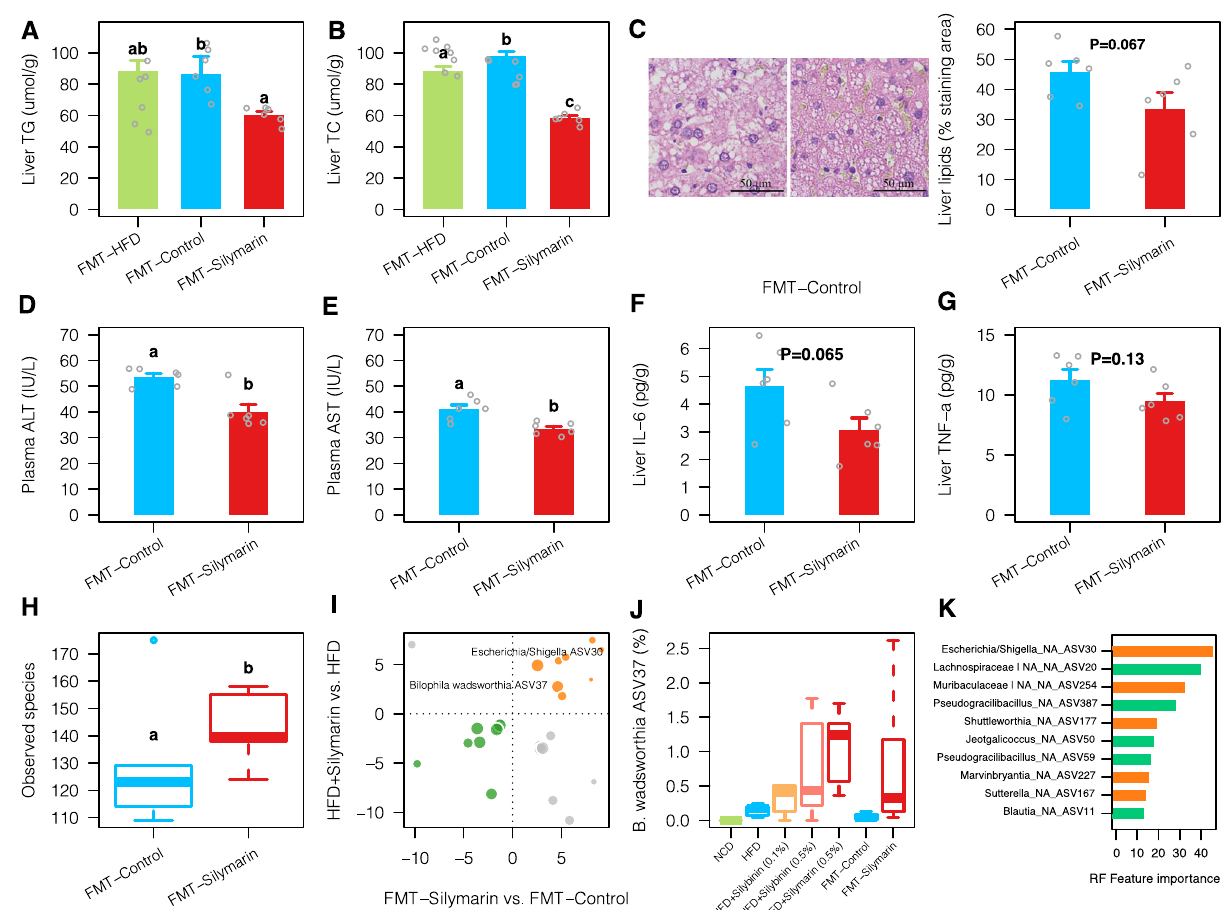
Fig. 3 | Liver lipids and associated gut microbiota changes after fecal micro- biota transplantation (FMT) to rats fed on high-fat diet for 12 weeks. Levels of liver TG ( A ) and TC ( B ) together with representative microphotograph of hema- toxylinandeosin(H&E)staining( C );levelsofplasmaALT( D )andAST( E );andlevels of liver IL-6 ( F ) and TNF- α ( G ) after FMTfor 12 weeks using fecal samples collected from silymarin-treated rats with (FMT-control) or without heat-killing (FMT-Sily- marin). Two-sided Wilcox rank-sum test was used to access the group differences; groups labeled with different letters (a, b, or c) indicate signi fi cant statistical dif- ferences(FDRadjusted P <0.05).Forbarplots,valueswereshownasmean±S.E.M. H The differences of alpha diversity in FMT-Control vs. FMT-Silymarin (one outlier within the FMT-Control group as shown in the boxplot was removed for the sta- tistical analysis). I The log2 fold changes of amplicon sequence variations (ASVs)